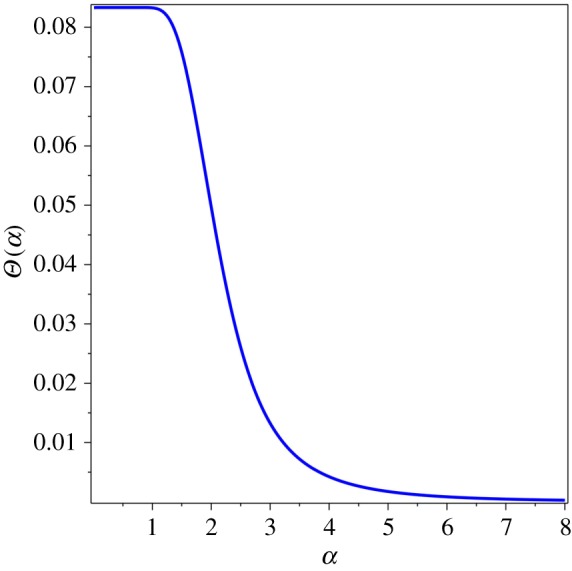
Θ(α) for n = 10 000.